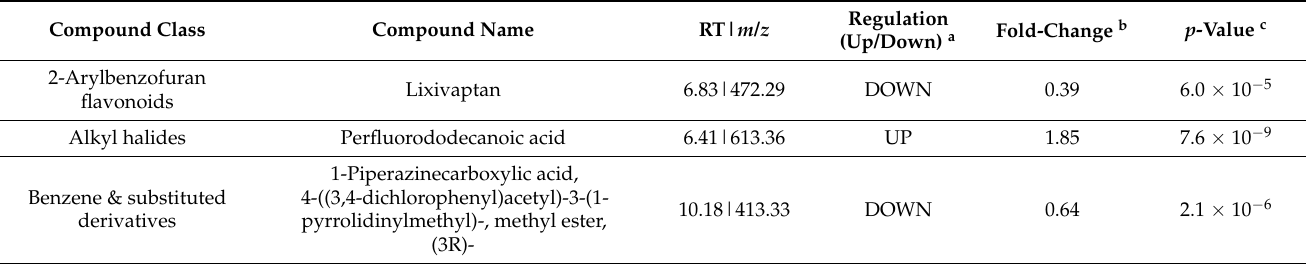
Table 2. List of annotated significantly altered metabolomic